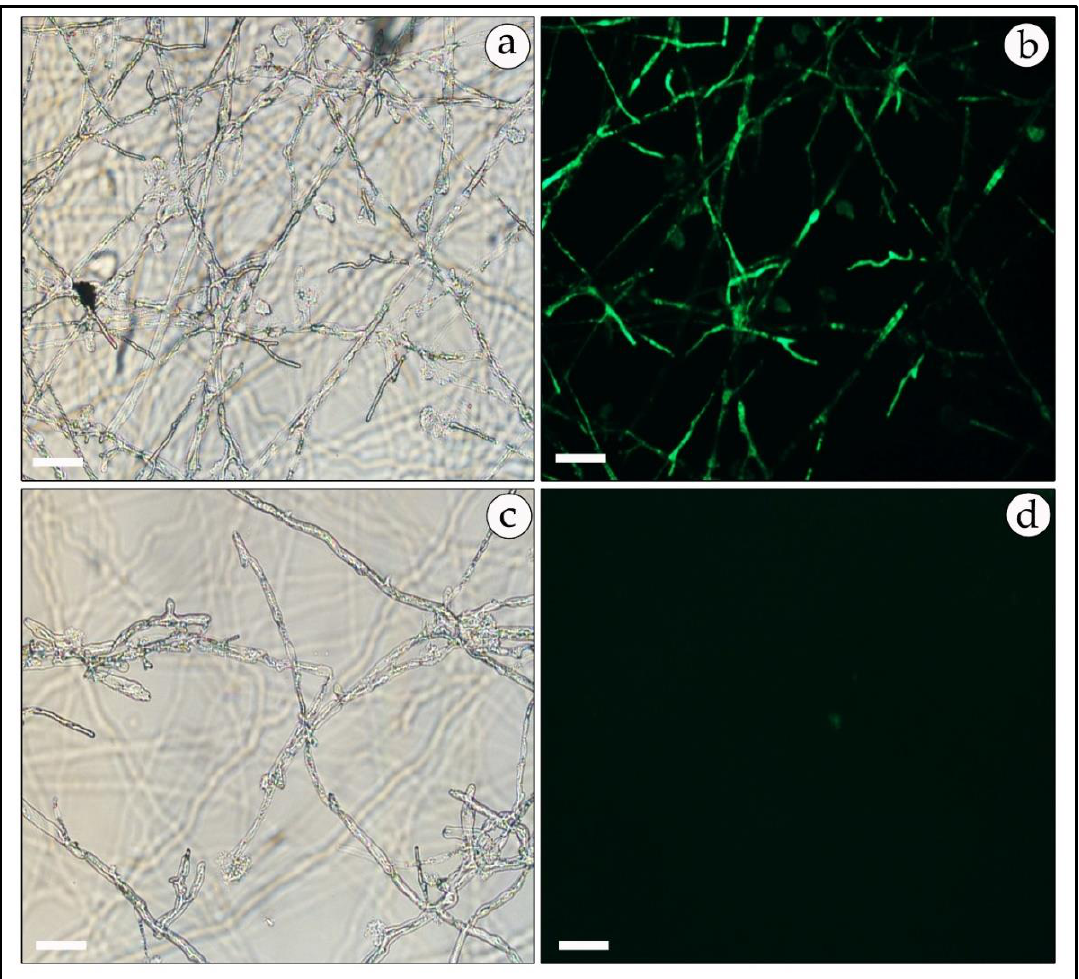
Figure 7. Fluorescent micrograph of GFP-expressing, geneticin-resistant mycelia of T. boudieri . Transformed mycelia were observed under florescent microscopically. Left panels: bright field; right panels: fluorescence microscopy. Panels ( a , b )—mycelia of GFP-expressing transformants; panels ( c , d )—non-transformed mycelia. 200 × magnification. Bar = 20 µ